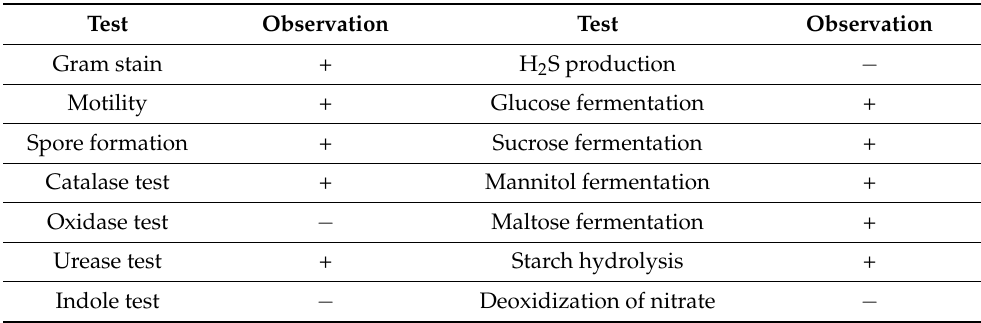
Table 2. Morphological and biochemical characterization of PHB-producing organism (AS-02 isolate). (+) positive response to the test and ( − ) negative response.